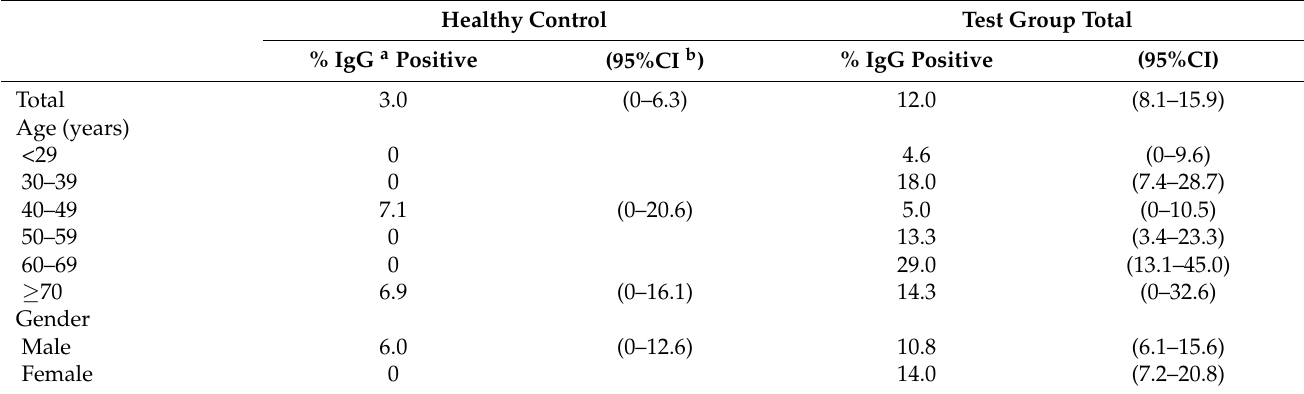
Table 2. Seroprevalence of anti-HEV IgGs in healthy control and test